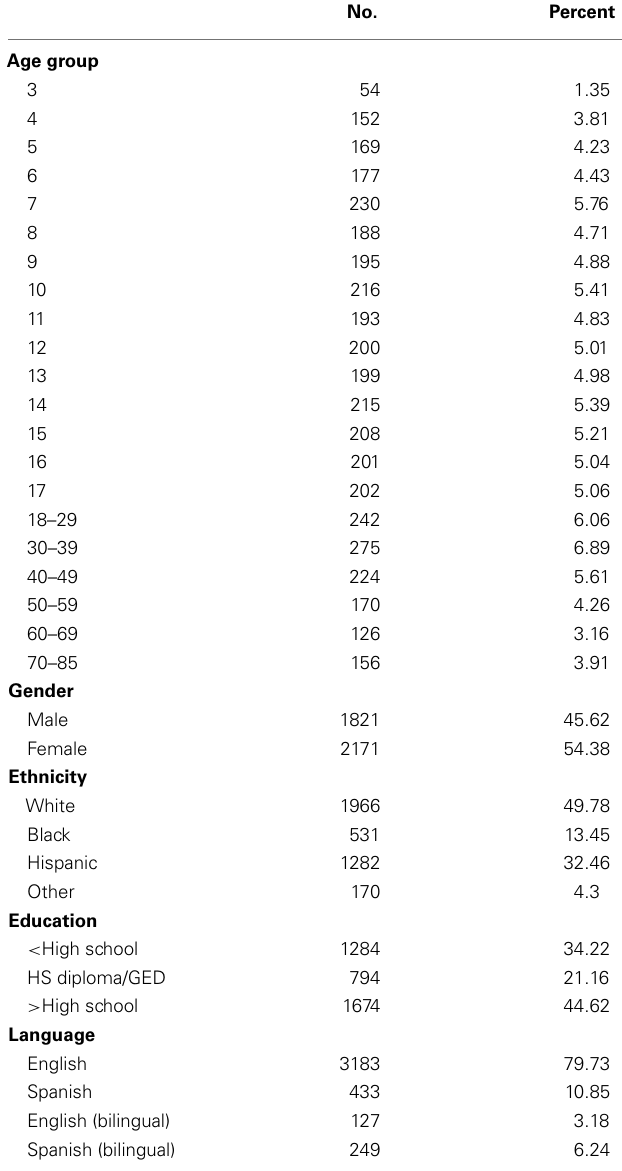
Table 1 | Normative population characteristics . ( Table 3 ). cDVA scores were significantly higher for